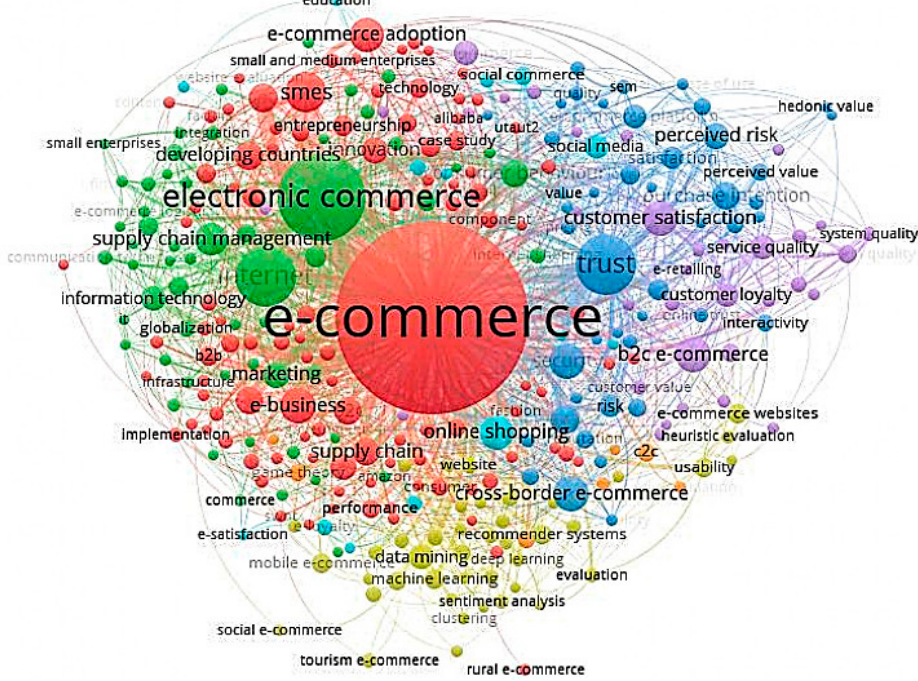
Figure 1. A map showing thematic focuses of scientific publications released between 2000 and 2020. Source: created with VOSviewer using data from Scopus.